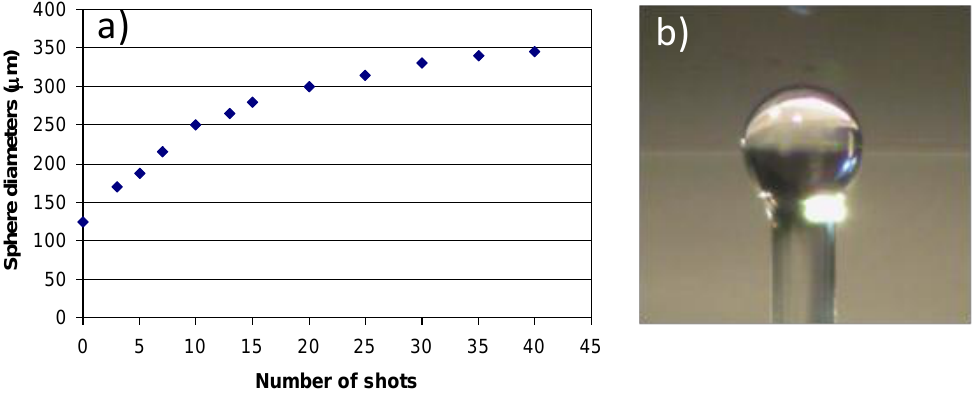
Figure 7 . (a) Size of the microspheres produced at the tip of a standard 125  m telecom fiber, as a function of the arc shots in a commercial fiber fusion splicer. (b) Optical image of a microsphere with a diameter of about 250  m. In the background (out of focus) one can see the coupling bi-conical tapered